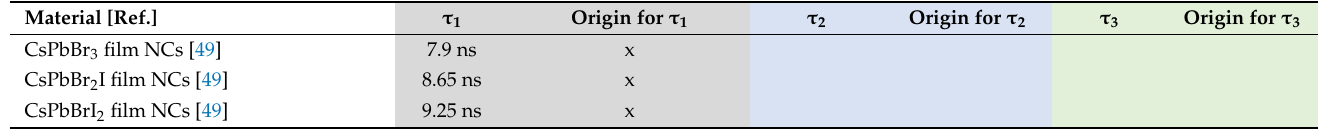
Table 1. List of some recent TRPL measurements for CsPbBr 3 and CsPbBr 3 − x I x materials. Col- umn 1, labeled ‘Material’, indicates the type of material investigated along with reference number. Columns 2, 4 and 6, labeled ‘ τ 1 (cid:48) , ‘ τ 2 (cid:48) and ‘ τ 3 (cid:48) , respectively, are the TRPL lifetimes measured in the associated studies. Columns 3, 5 and 7, labeled ‘origin of τ 1 (cid:48) , ‘origin of τ 2 (cid:48) and ‘origin of τ 3 (cid:48) , respectively, are the physical origin of the lifetimes in columns 2, 4 and 6, respectively, according to the associated